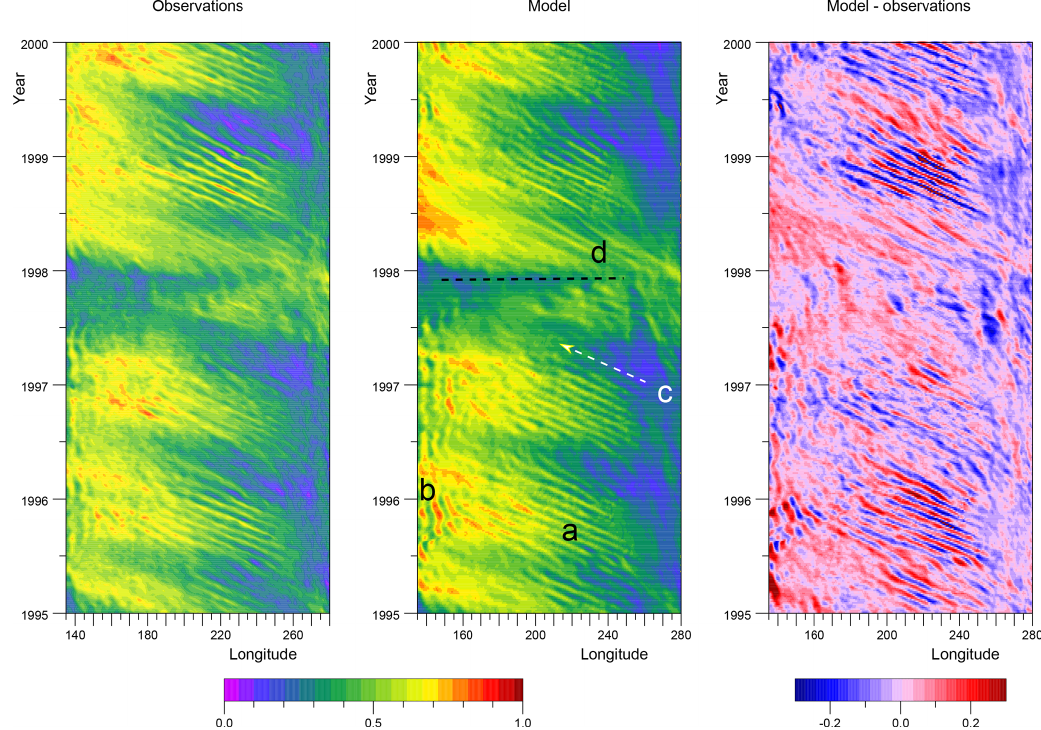
Figure 4. Observed and model sea surface height and their difference in the Pacific at a latitude of 6 ◦ N between 135 and 280 ◦ E (80 ◦ W), showing (a) westward-propagating tropical instability waves or eddies, (b) quasi-steady meanders near the start of the NECC, (c) westward- propagating annual Rossby wave and (d) transition event (see text). Units are